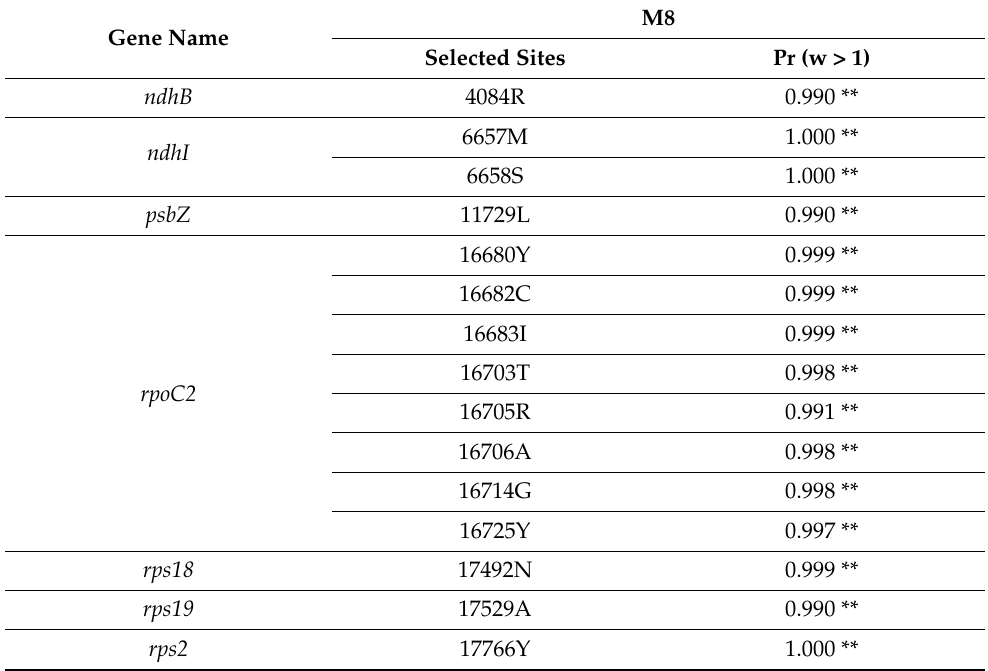
Table 4. Positively selected sites detected in the chloroplast genome of Rutaceae based of Bayes empirical Bayes (BEB)